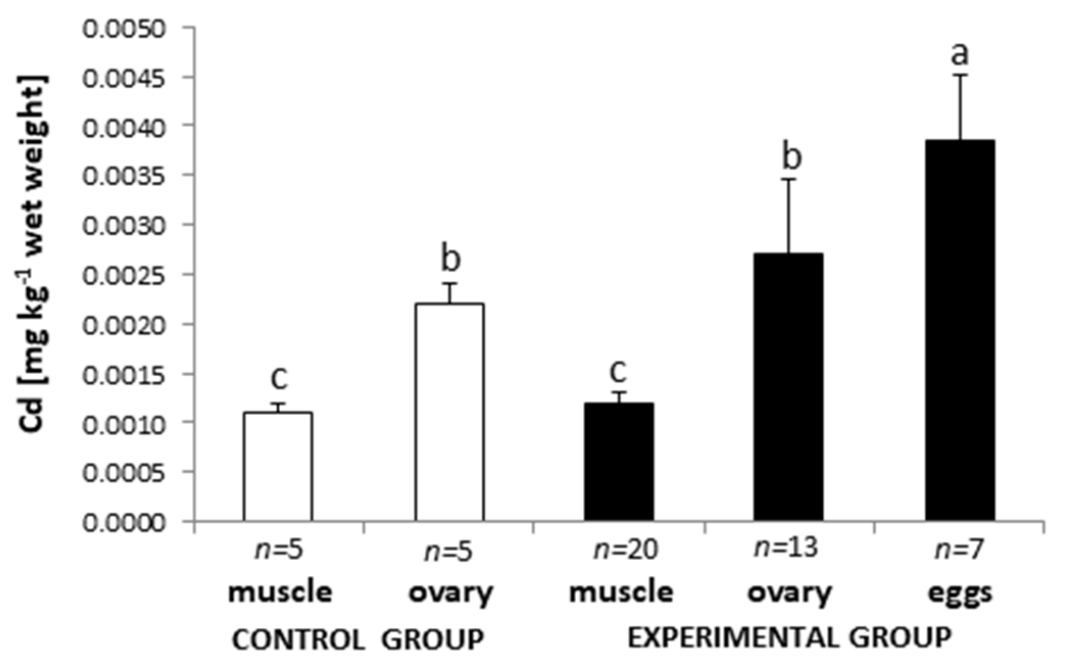
Figure 1. Cadmium content (mg kg − 1 wet weight) in muscle ( n = 5) and ovaries ( n = 5) of hormonally untreated and in muscles ( n = 20), ovaries ( n = 13), and eggs ( n = 7) of hormonally treated silver females European eel Anguilla anguilla . Data are presented as mean ± SD. Data marked with the same letter index (above the bars) do not differ statistically ( p > 0.05).